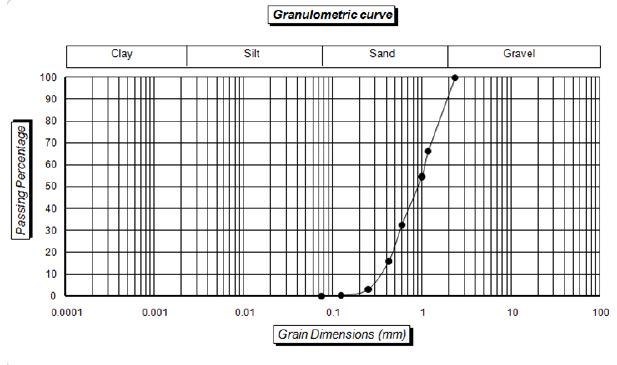
Fig. 3. Grain-size distribution curve of the sand utilized in the